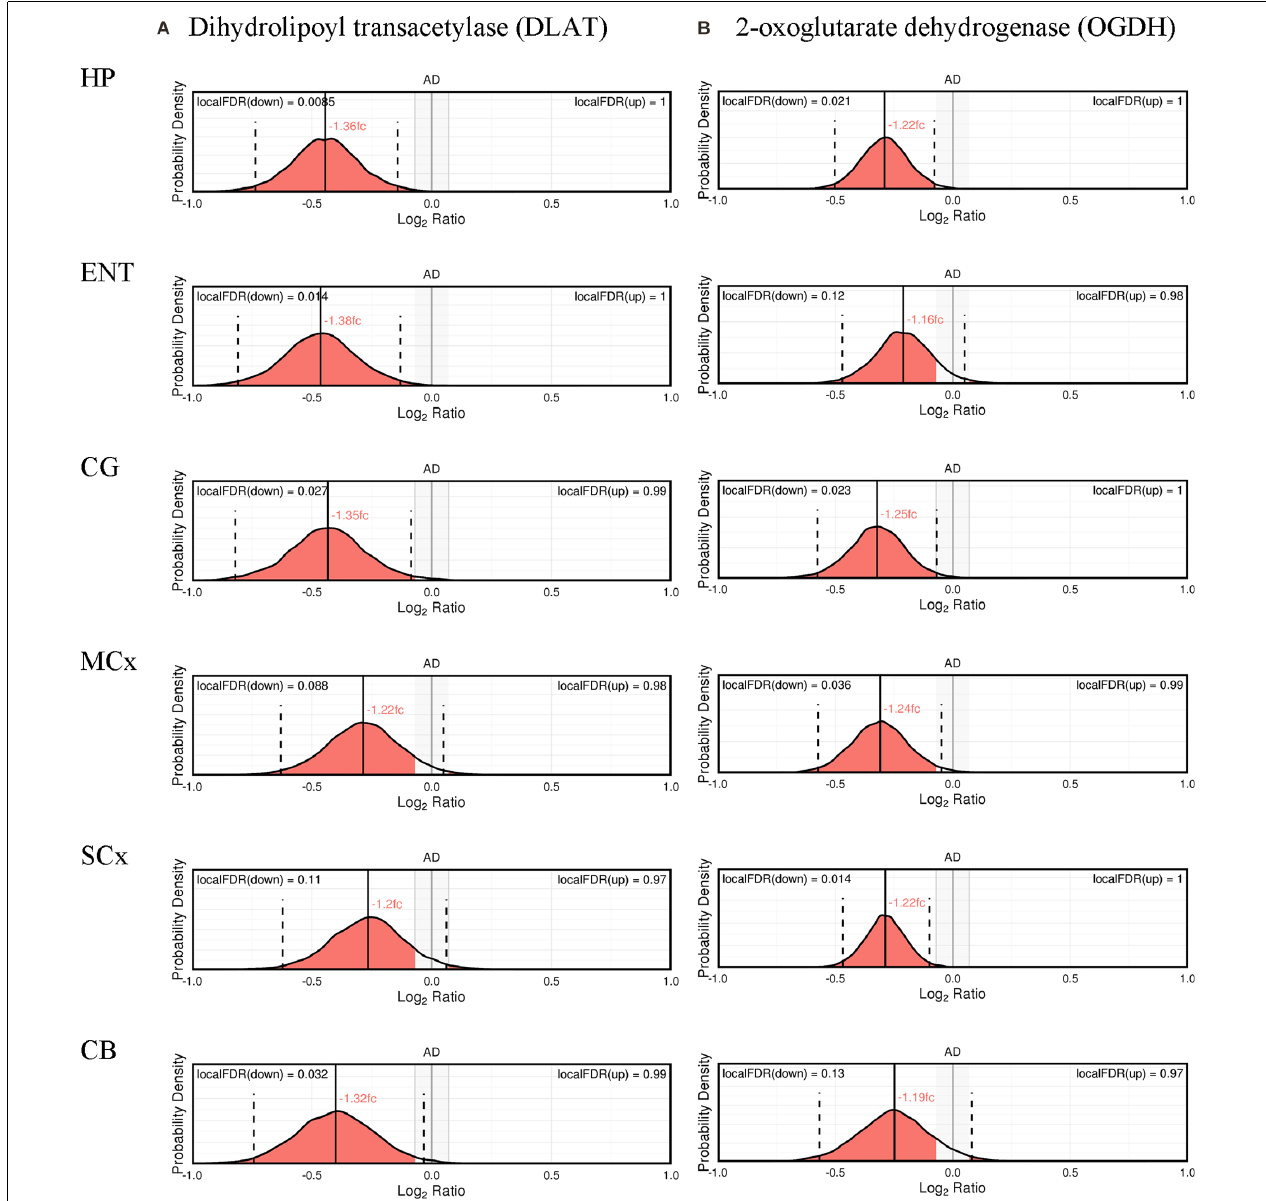
FIGURE 1 | Expression of cerebral dihydrolipoyl transacetylase (A) and 2-oxoglutarate dehydrogenase (B)